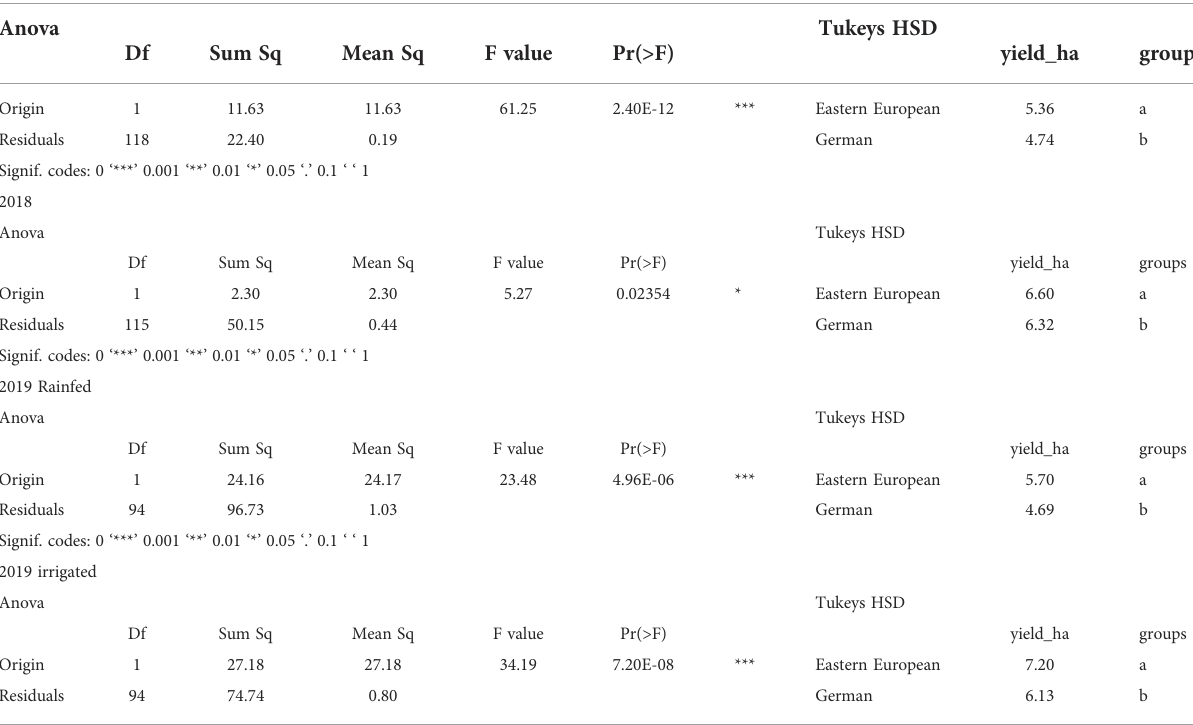
TABLE 3 Analyses of variance and Tukey-HSD test of grain yield, dependent on the origin of